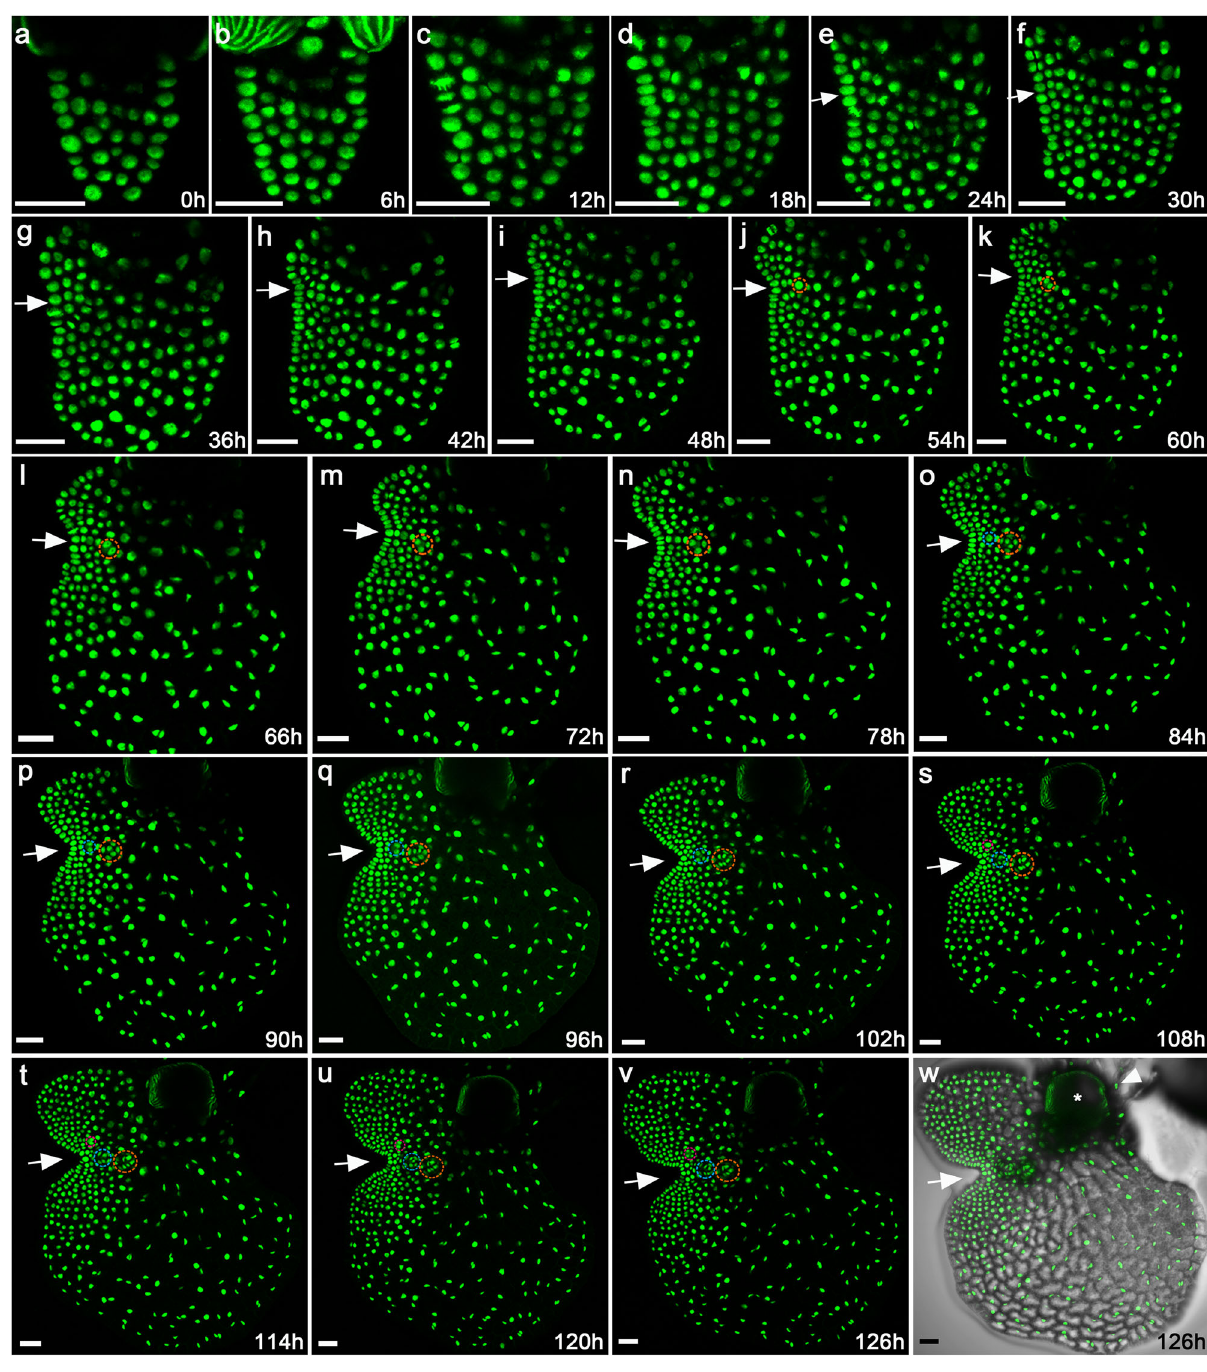
Fig. 2 Long-term time-lapse confocal imaging reveals cellular dynamics of meristem initiation and proliferation in the Ceratopteris gametophyte. a – v One hermaphroditic gametophyte expressing the nuclear marker H2B-GFP (at 5 DAI) was live-imaged through laser scanning confocal microscopy. The non-invasive time-lapse imaging was performed at 6-h intervals, from 0 h to 126 h. a – v Z-projection views of confocal images at the indicated time points are shown. White arrows indicate formation and proliferation of the multicellular meristem over time. Three archegonia subsequently formed next to the meristem, which are highlighted with the circles in different colors (orange, blue and pink). w Merge of the GFP ( v ) and DIC (showing the cell outlines) channels. The white asterisk indicates ruptured spore coat, and the white arrowhead indicates rhizoids. Scale bars: 50 μ m. Three independent biological replicates were included in this time-lapse imaging experiment with the same interval and duration, all showing similar patterns of prothallus cell proliferation. Two other samples were shown in Supplementary Figs. 4 and